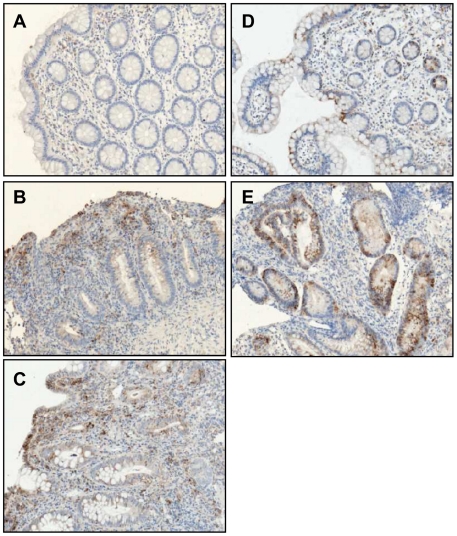
ER stress is mainly localized in epithelial secretory cells.Immunohistochemical analysis of HSPA5, a central mediator of ER stress, was performed on paraffin embedded slides of A. colonic controls, B. inflamed areas of colonic Crohn's disease (CD) patients, C. inflamed areas of ulcerative colitis patients, D. ileal controls and E. inflamed areas of ileal CD patients. The ER stress observed is linked to the epithelium rather than to recruited inflammatory cells.